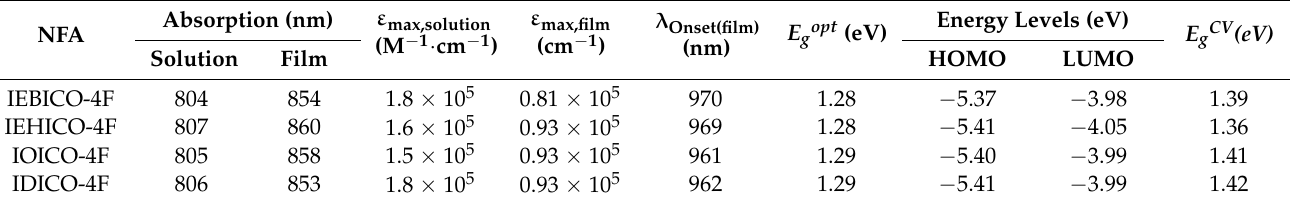
Figure 1. ( a ) Chemical structures of PTB7-Th and NFAs in this study. ( b ) Normalized UV/Vis absorption spectra of the NFAs in chloroform solution (thick line) and thin films (dotted line), ( c ) cyclic voltammetry plots of the NFAs, ( d ) Schematic energy levels diagram of PTB7-Th and the NFAs. Table 1. Optical and electrochemical properties of